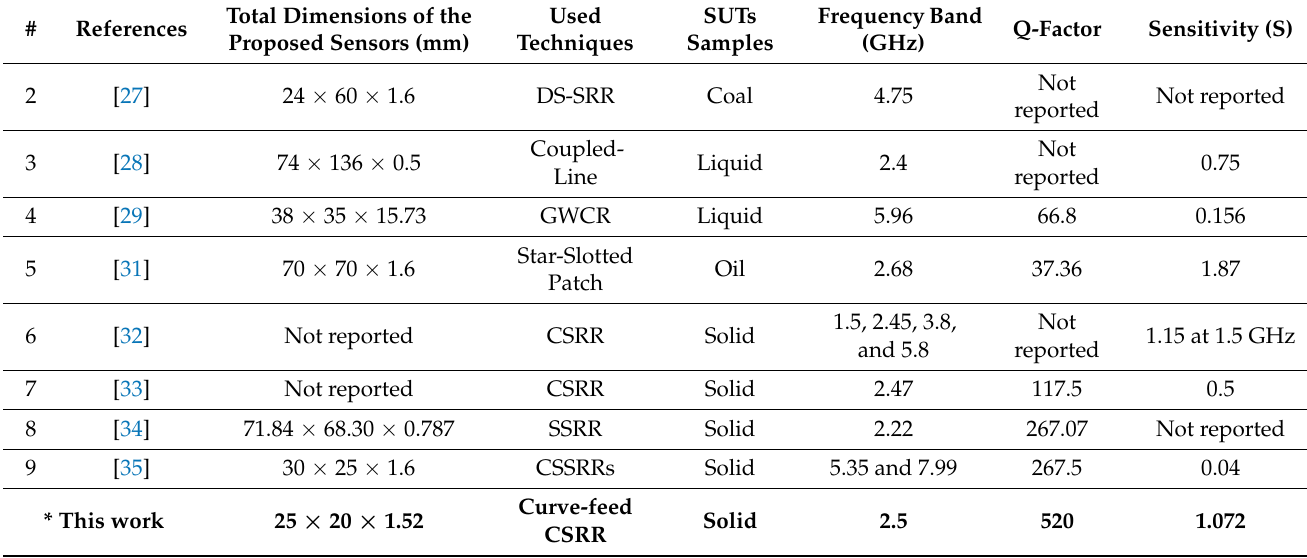
Table 1. Cont. Table 1. Detailed comparison of state-of-the-art technology of curve-feed CSRR sensor for material detections with the existing literature.